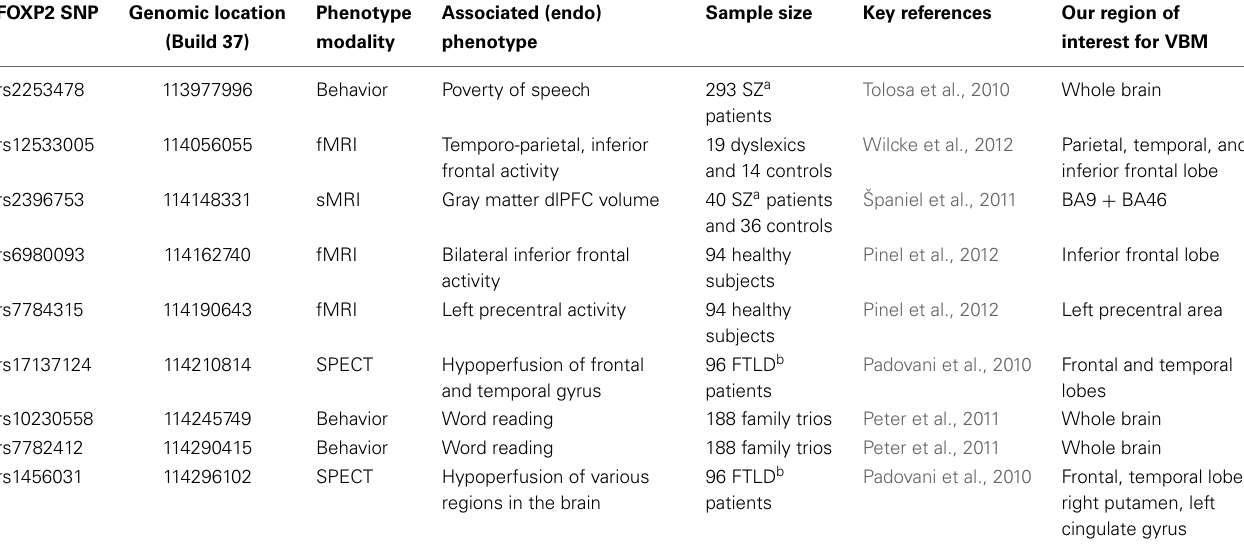
Table 1 | Overview of previous studies of common variation in FOXP2 and our corresponding regions of interest for VBM analysis. FOXP2